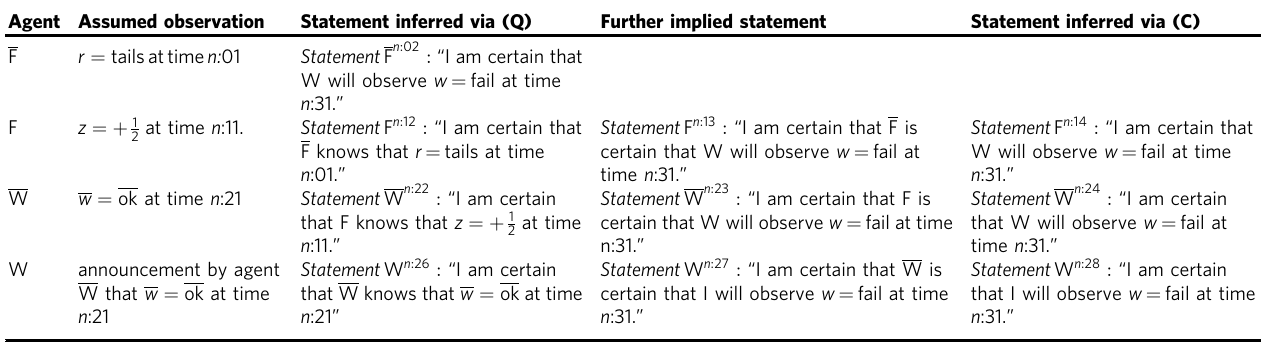
Table 3 The agents ’ observations and conclusions